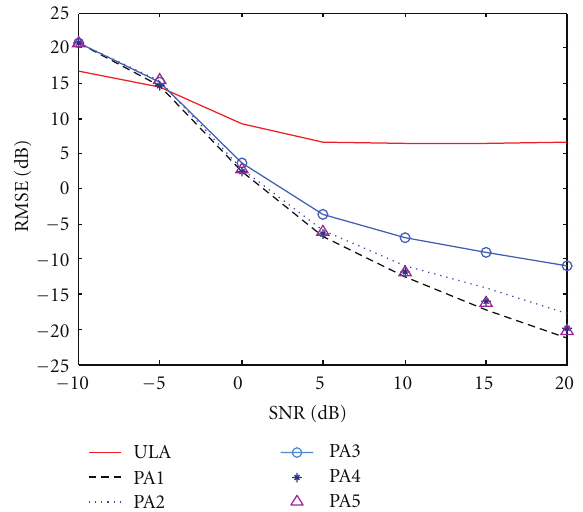
Figure 13: Total RMSE of the MVDR algorithm for di ff erent combined array configurations in scenario 2.